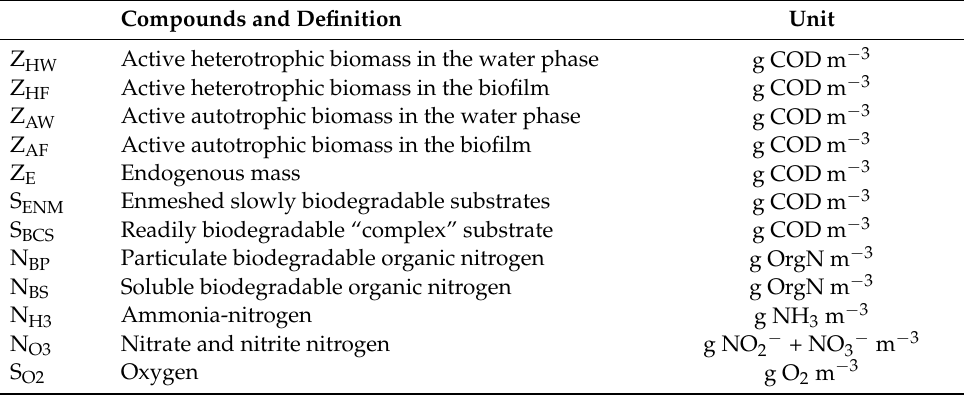
Table 2. The definitions of compounds.